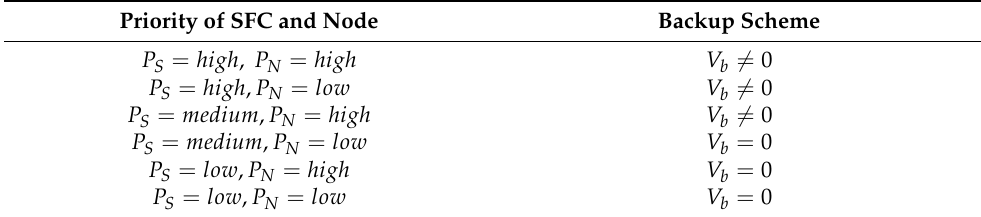
Table 1. Backup scheme in different priority